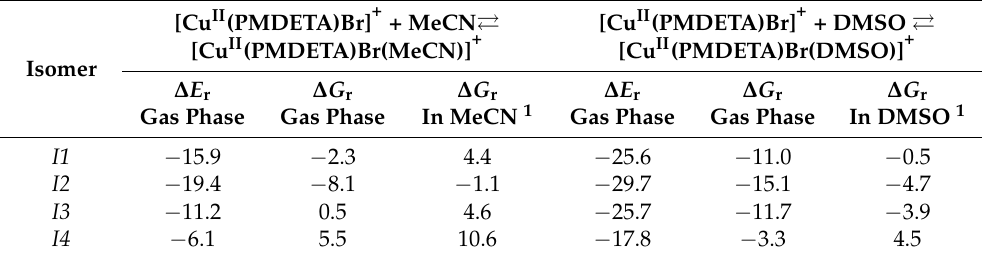
Table 5. Δ G r (kcal/mol) of the coordination reaction of [Cu II (PMDETA)Br] + with a solvent molecule calculated in gas phase and in implicit solvent; level of theory: (PCM-)M06/6-311+G(d,p).